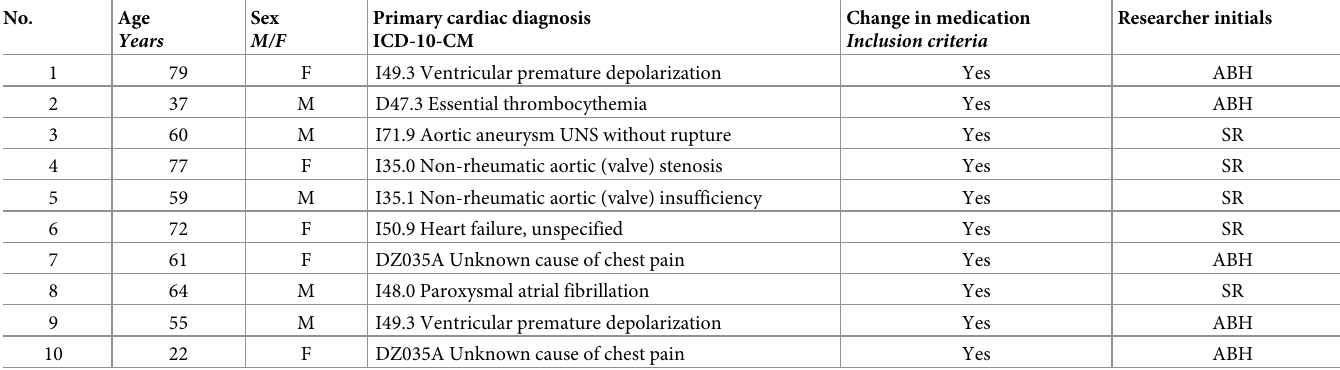
Table 4. Patient characteristics, qualitative